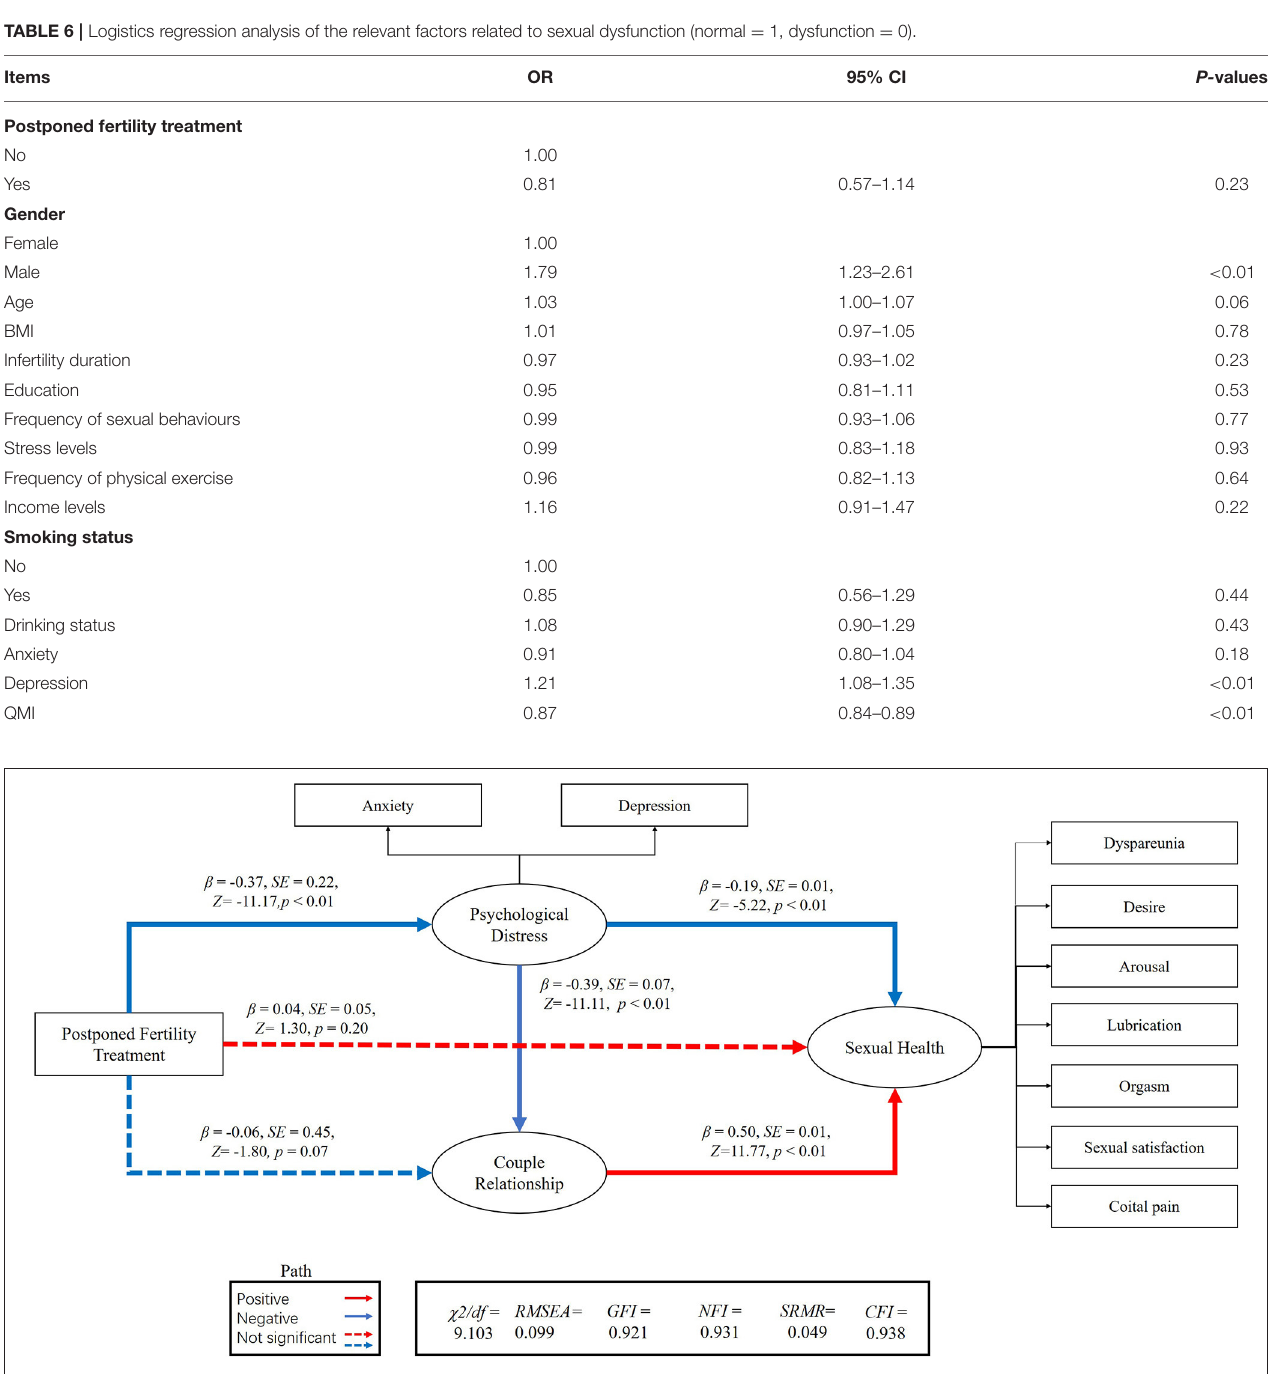
TABLE 6 | Logistics regression analysis of the relevant factors related to sexual dysfunction (normal = 1, dysfunction = 0).